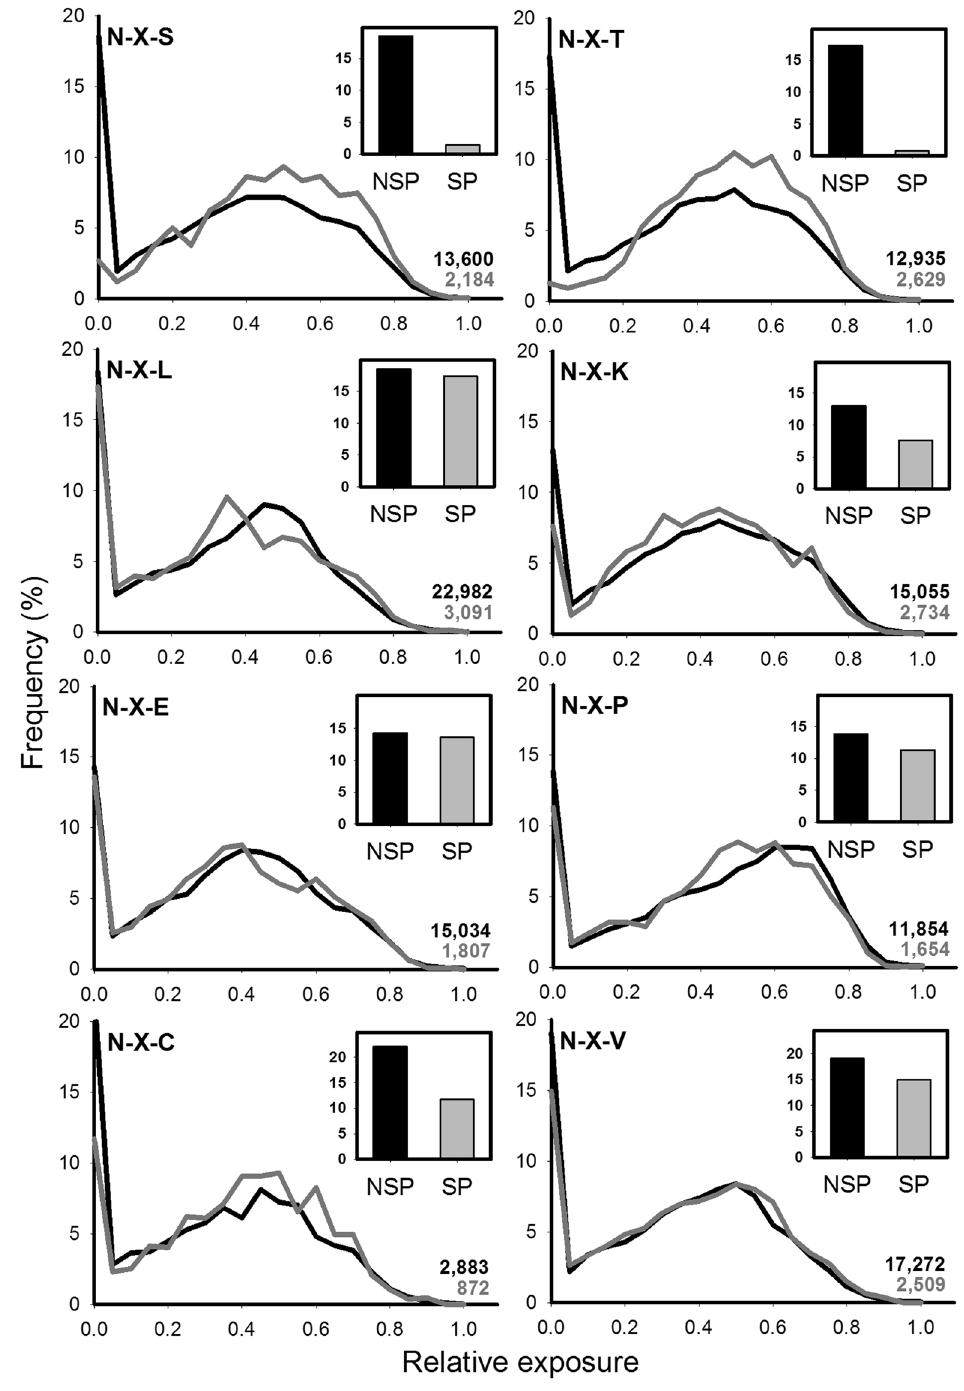
Figure 3. Surface exposure distribution of Asn residues in SP and in NSP proteins. The main graphs show the distribution of exposure of Asn residues in the selected tripeptides for NSP (black lines) and SP proteins (gray lines), where X can be any residue. The total number of Asn analyzed for NSP and SP proteins is indicated in black and gray, respectively. Inset show the percentage of buried Asn in each curve (exposure values below <